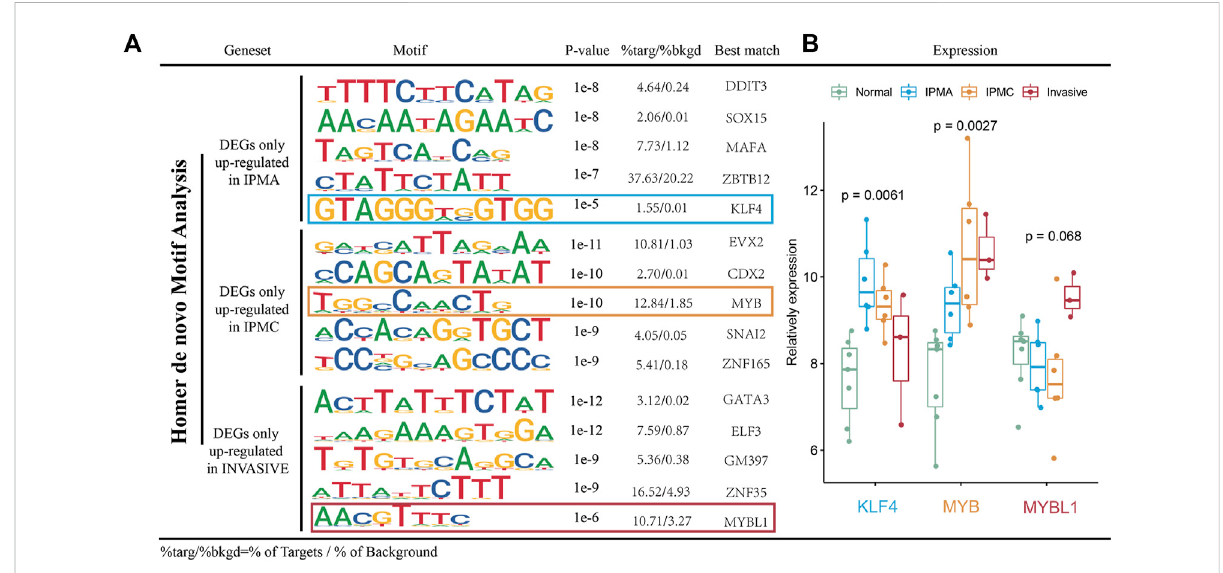
FIGURE 6 MotifanalysisofDEGs. (A) Top5enrichedknownmotifsaspredicted via Homeranalysisindifferentstages. (B) RelativemRNAexpressionofkey TFs in different disease stage